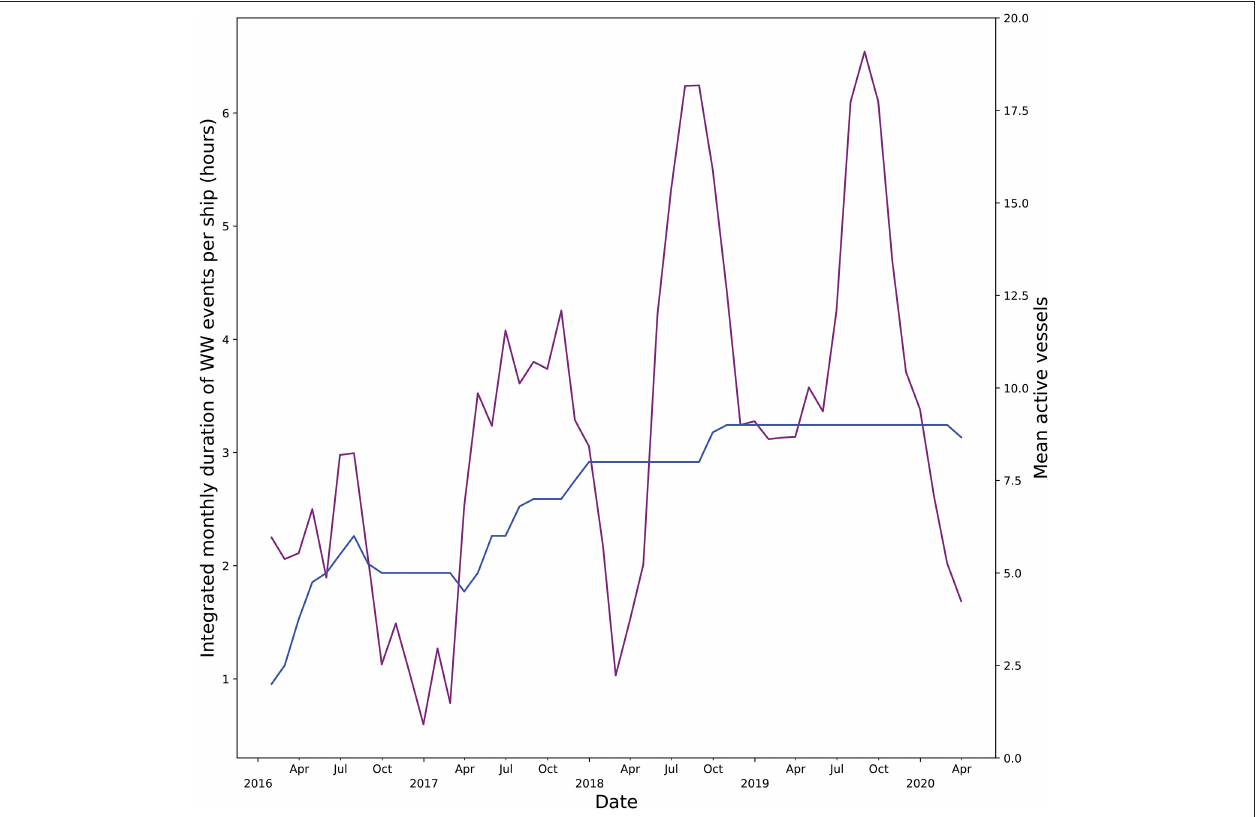
FIGURE 7 | Total integrated monthly duration of whale watching events off south Tenerife normalized by mean active vessels (red line). Mean number of active vessels (blue